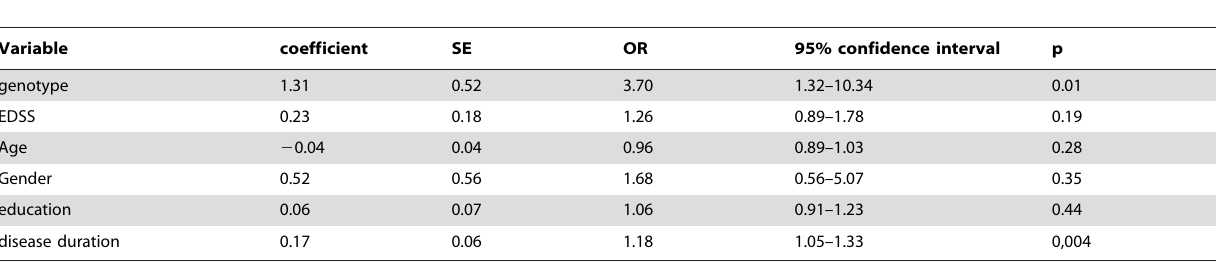
Table 3. Logistic regression (overall CI as response variable).